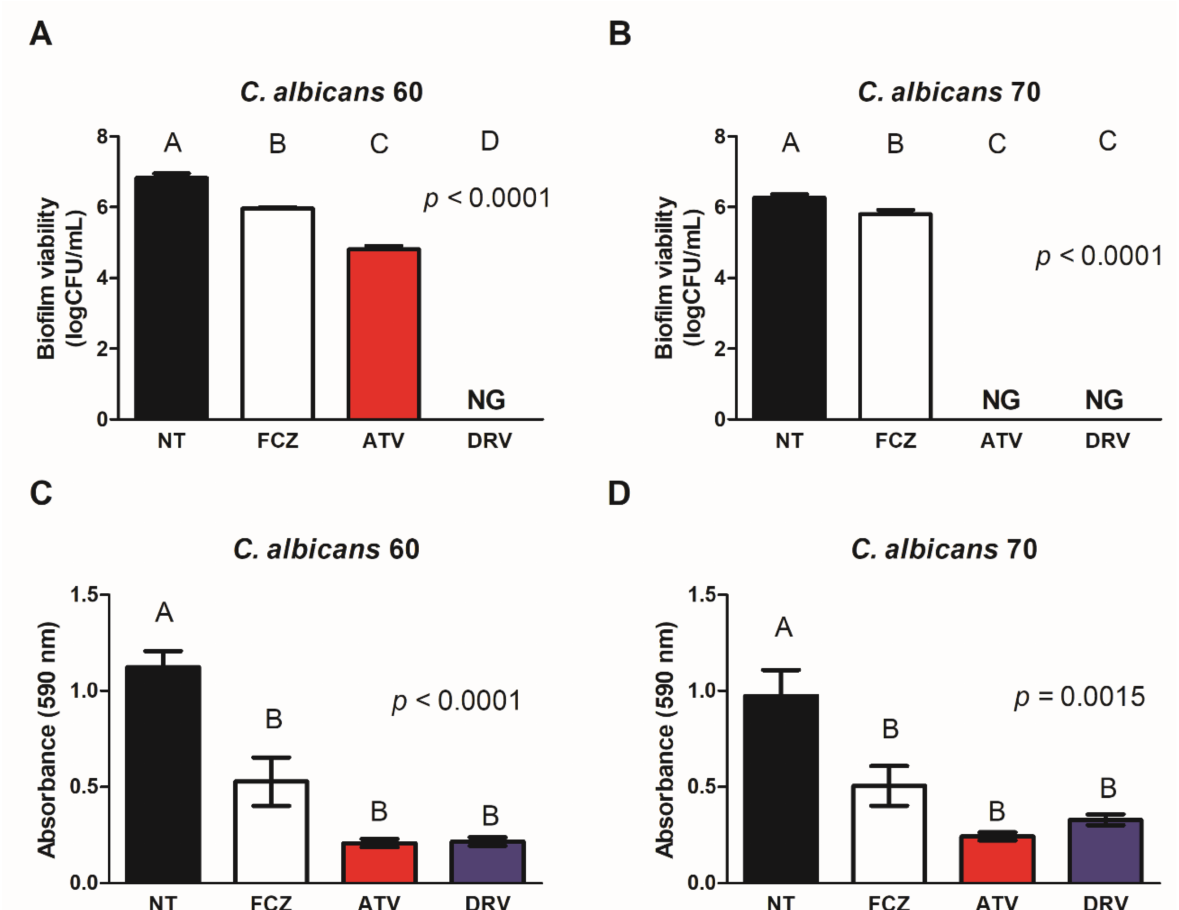
Figure 1. ATV and DRV reduced the viability and biomass of Candida albicans biofilms. Fungal viability of biofilms of ( A ) C. albicans 60 (Ca60) and ( B ) C. albicans 70 (Ca70) not treated (NT) and treated with fluconazole (FCZ), darunavir (DRV), and atazanavir (ATV). Biofilm biomass of ( C ) Ca60 and ( D ) Ca70 without treatment (NT) and after treatment with FCZ, DRV, and ATV. Results represent the mean of three replicates. FCZ: fluconazole; DRV: darunavir; ATV: atazanavir; NT = not treated; NG = no growth. Different letters (A, B, C, D) indicate significant differences ( p <